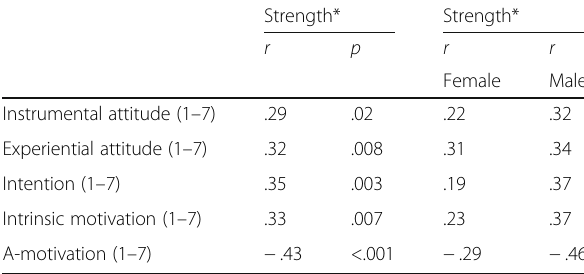
Table 3 Correlations between strength and psychological outcomes ( n = 68)